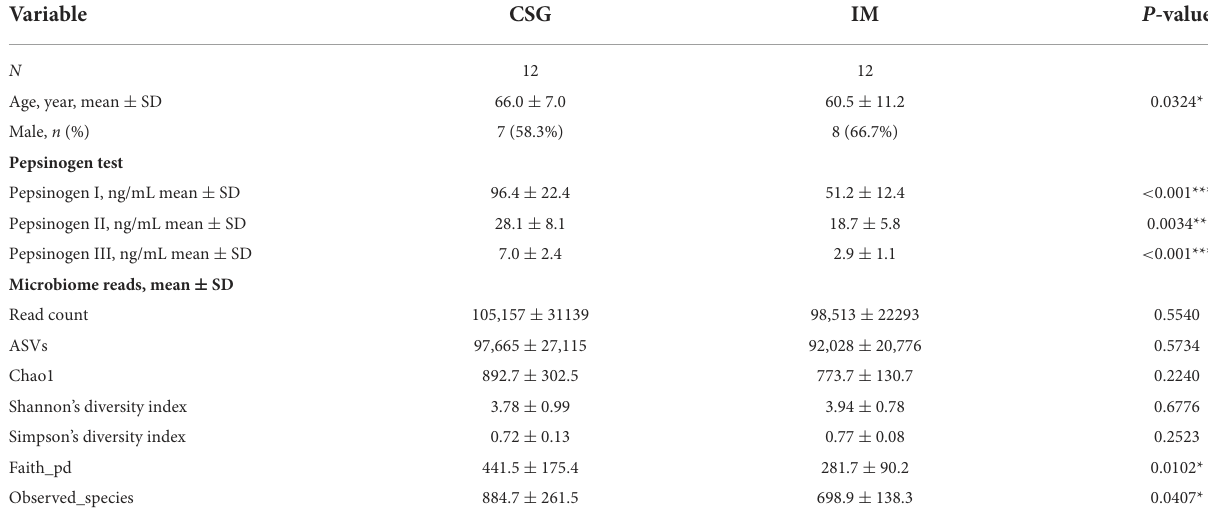
TABLE 3 Baseline patient characteristics and microbiome reads of samples.